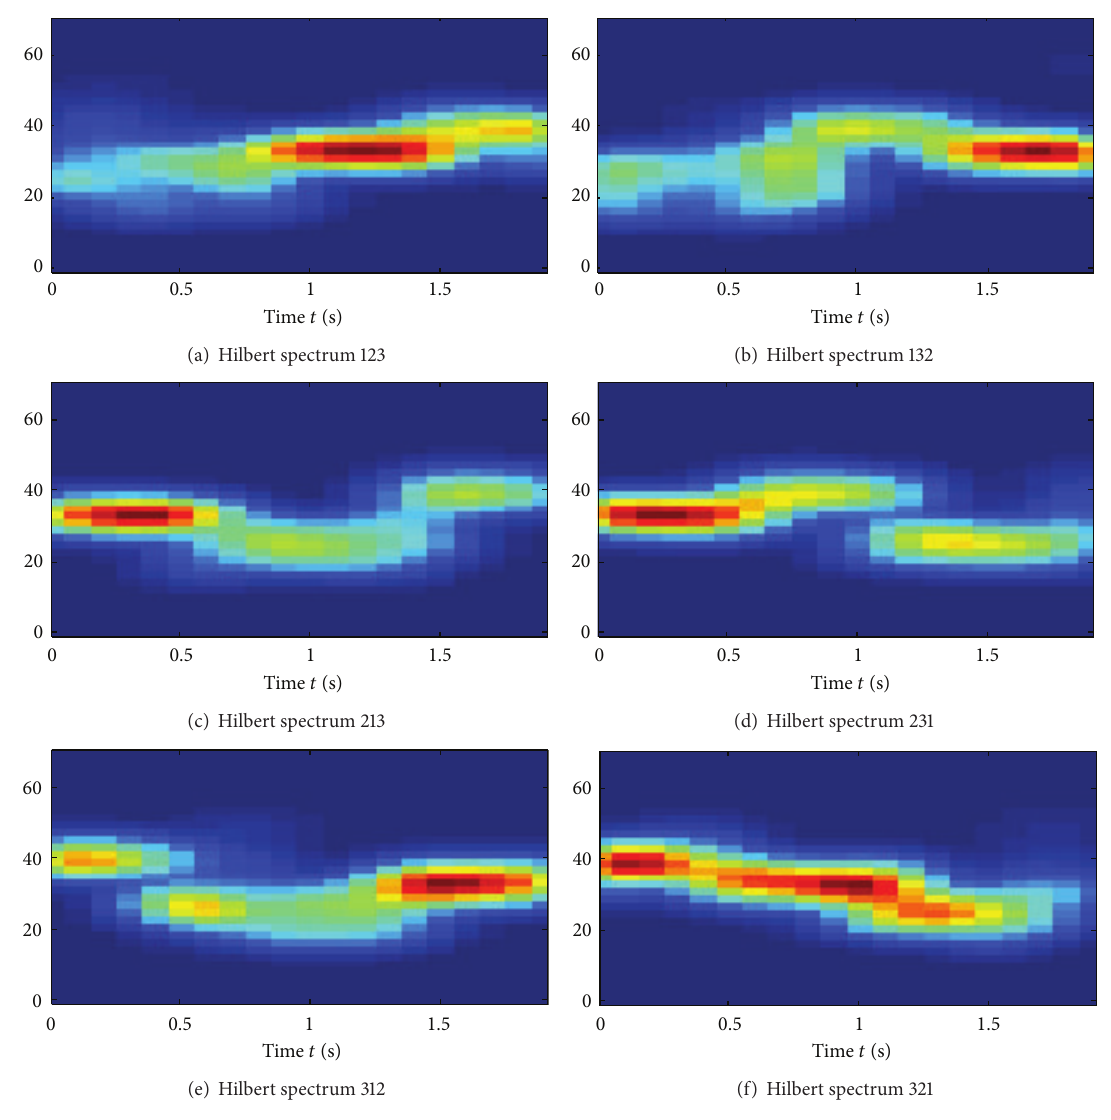
Figure 12: The Hilbert spectra of HFCC-SSVEP.